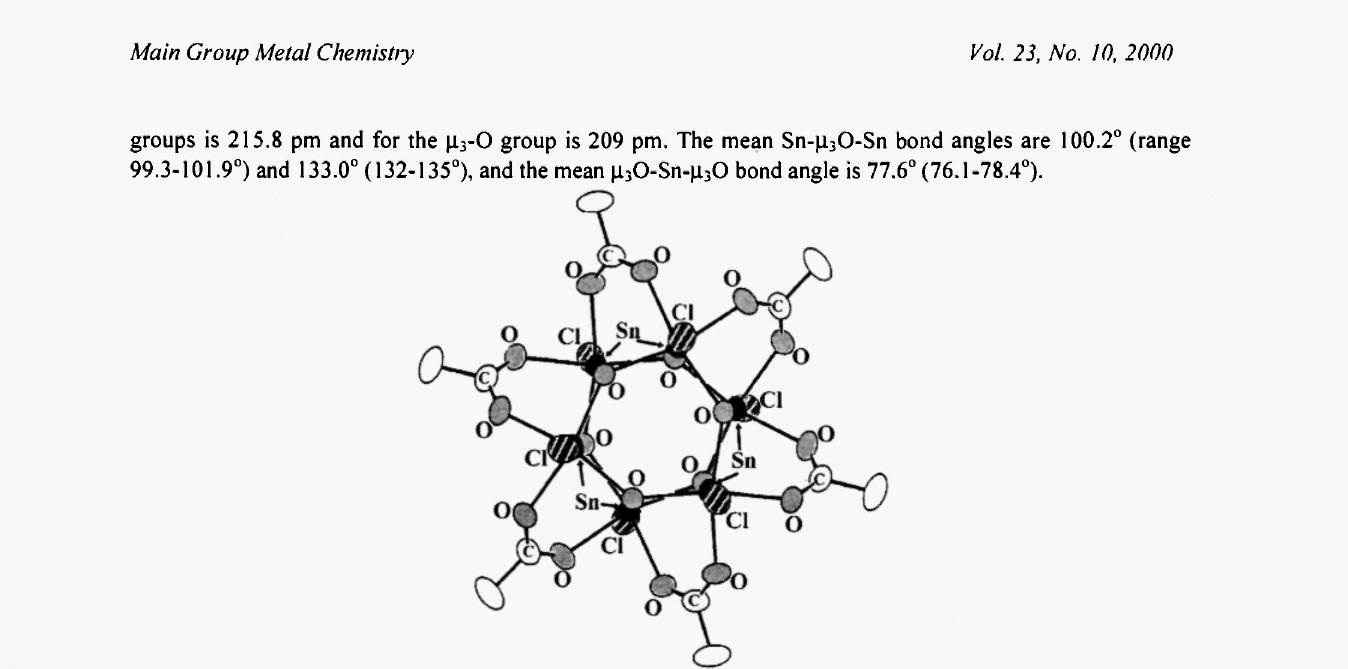
Fig. 9. Structure of |MeSn^ 3 -0)^-l,3-0 2 CMe)| 6